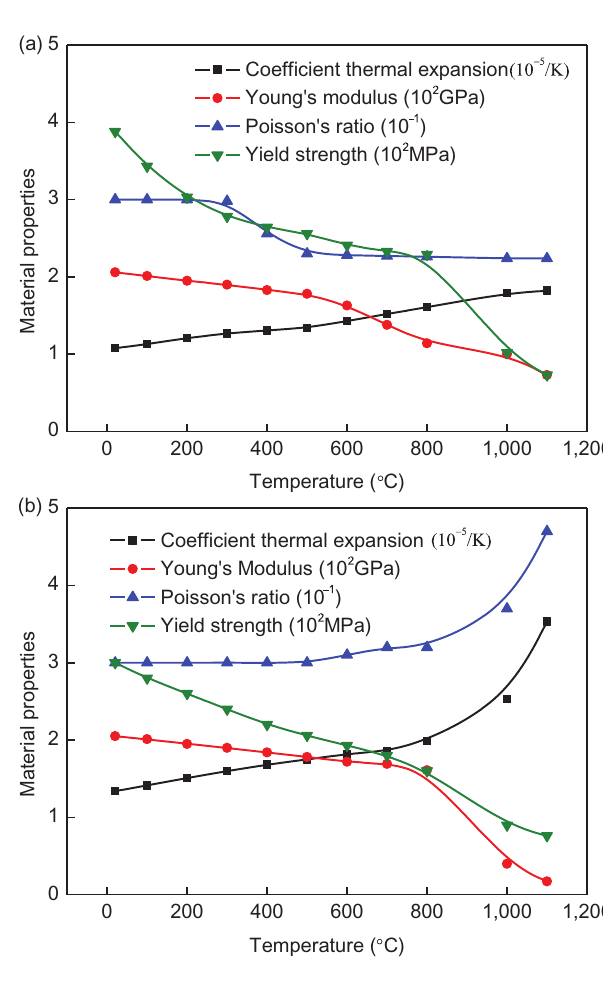
Figure 4: Material properties of Hastelloy C-276 (a) and BNi-2